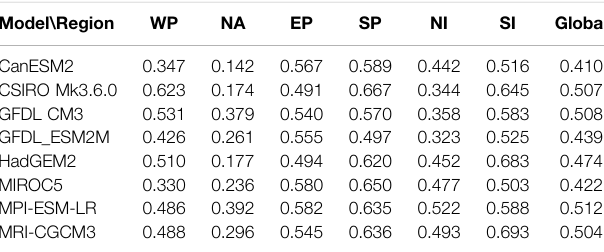
TABLE 1| Index ofTCtrack density weightedby TCdestructive potential foreight CMIP5 climate models in different areas and globe (WTD). Model\Region